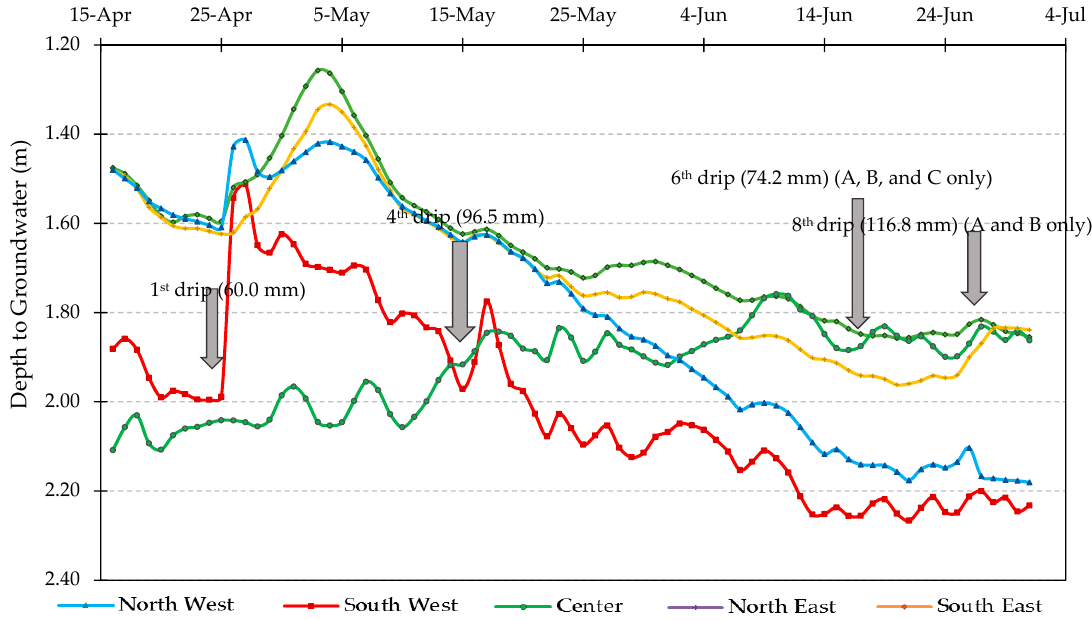
Figure 7. Depth to groundwater (m) for the five observation wells from 16 April to 1 July.